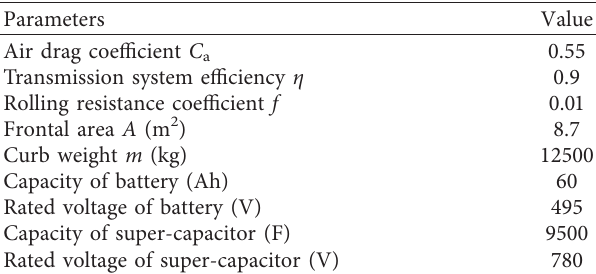
Figure 7: The flow chart of VSO-FEMS strategy. Table 7: Parameters of electric vehicle